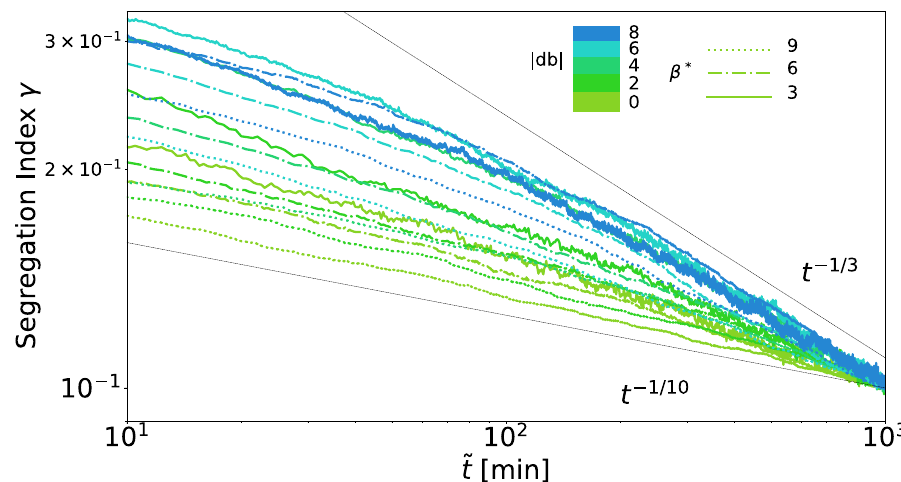
Fig 8. A 1/3 exponent forms an upper bound for the pseudo-algebraic scaling in cellular automaton. Segregation indices obtained from the simulation are shown for a range of the effective parameters db and β � , but only for the last two orders of magnitudes in time ~ t before the segregation index reaches γ = 0.1 in each simulation. For comparability, the time scale of each simulation is set such that all simulations reach γ = 0.1 at ~ t ¼ 1 . For each simulation we use 100 2 cells, a cell type ratio of 50/50, periodic boundary conditions, and a random mixture γ = 0.5 as initial configuration.